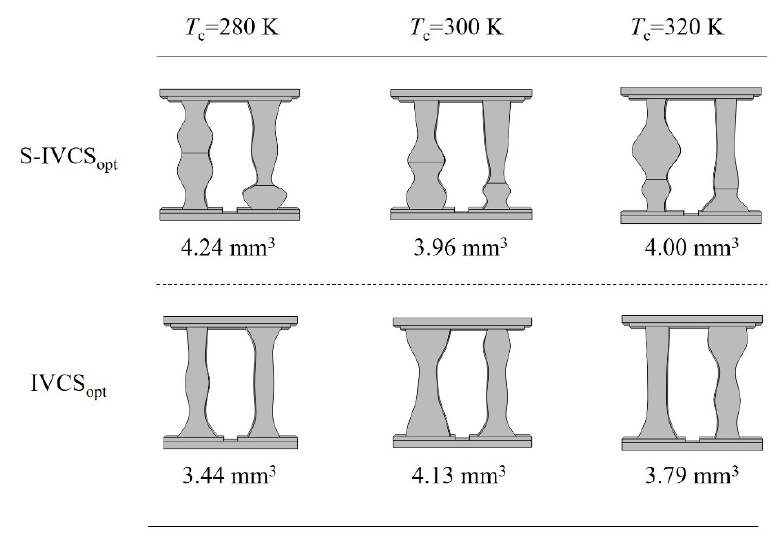
Figure 11. The optimized structures for S-IVCS and IVCS at T c =280 K, 300 K, and 320 K.